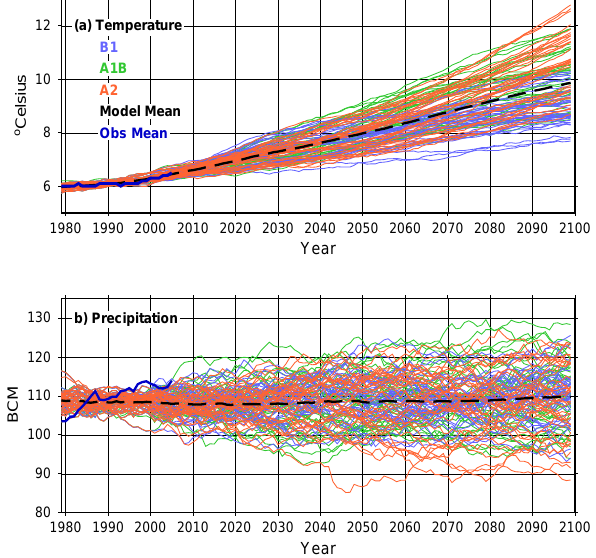
Fig. 3. ECDFs of annual average temperature and total precipitation averaged over the Upper Colorado River Basin above Lees Ferry, Arizona for the period 1950–1999. The downscaled forcing ensem- ble from 112 GCM projections (light blue), and their mean, is com- pared with observed (a) temperature and (b) precipitation calculated from the Maurer et al. (2002) dataset.